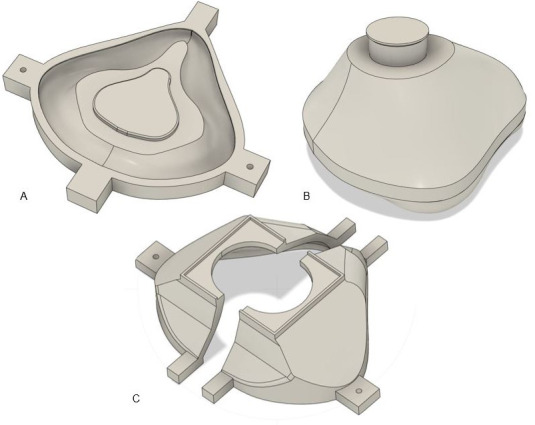
The final design of each mold part is shown; (a) base, (b) middle, (c) top cover with left and right halves.